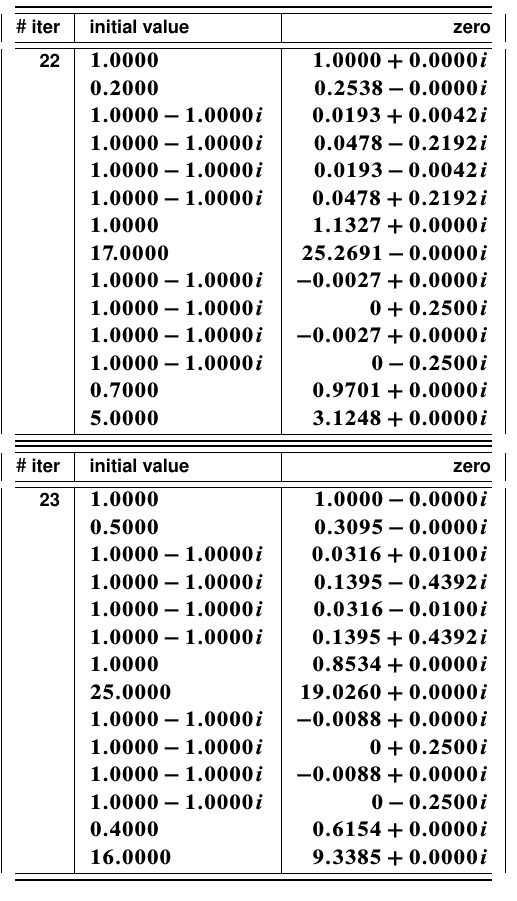
Table 1. Initial values applied to the Newton downhill method and the corresponding convergent results, as well as the number of iterations required to